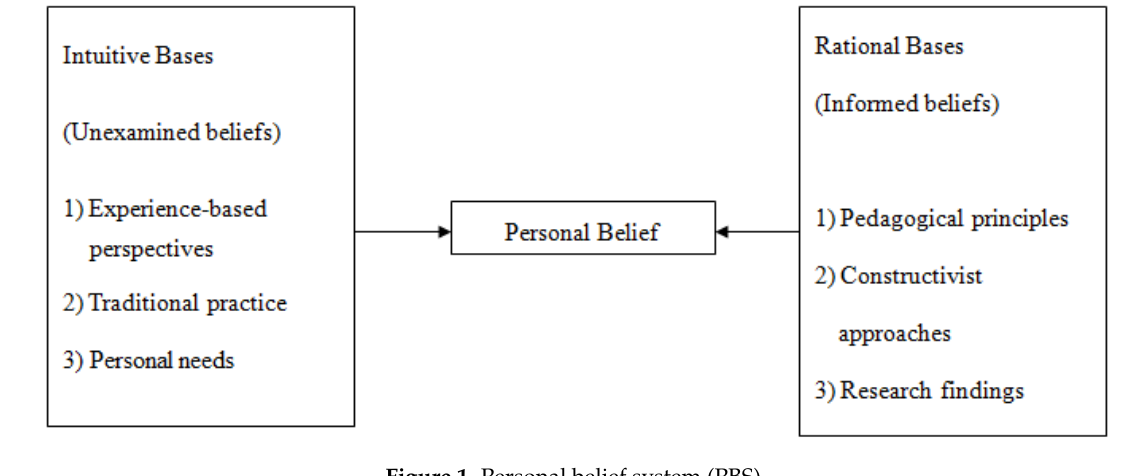
Figure 1. Personal belief system (PBS).